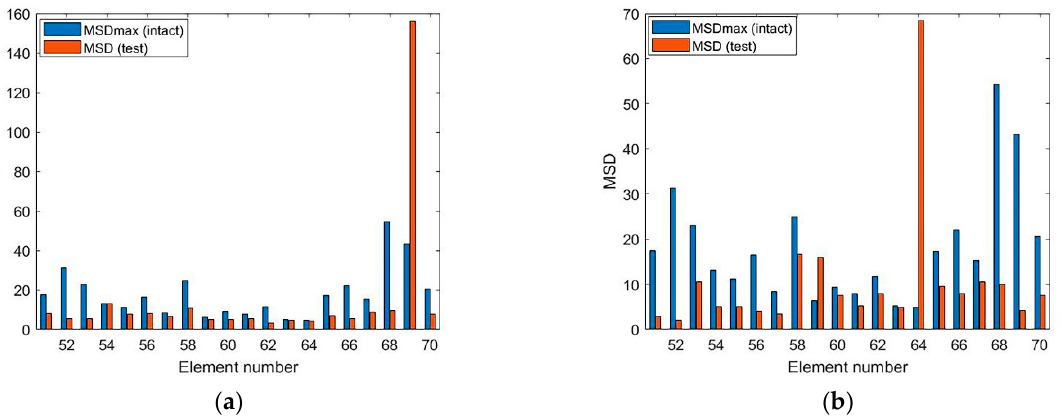
Figure 8. ( a ) Single-damage of the 69th element under Chi-Chi earthquake; ( b ) multi-damage of the 59th and 64th elements under Chi-Chi earthquake. 59th and 64th elements under Chi-Chi